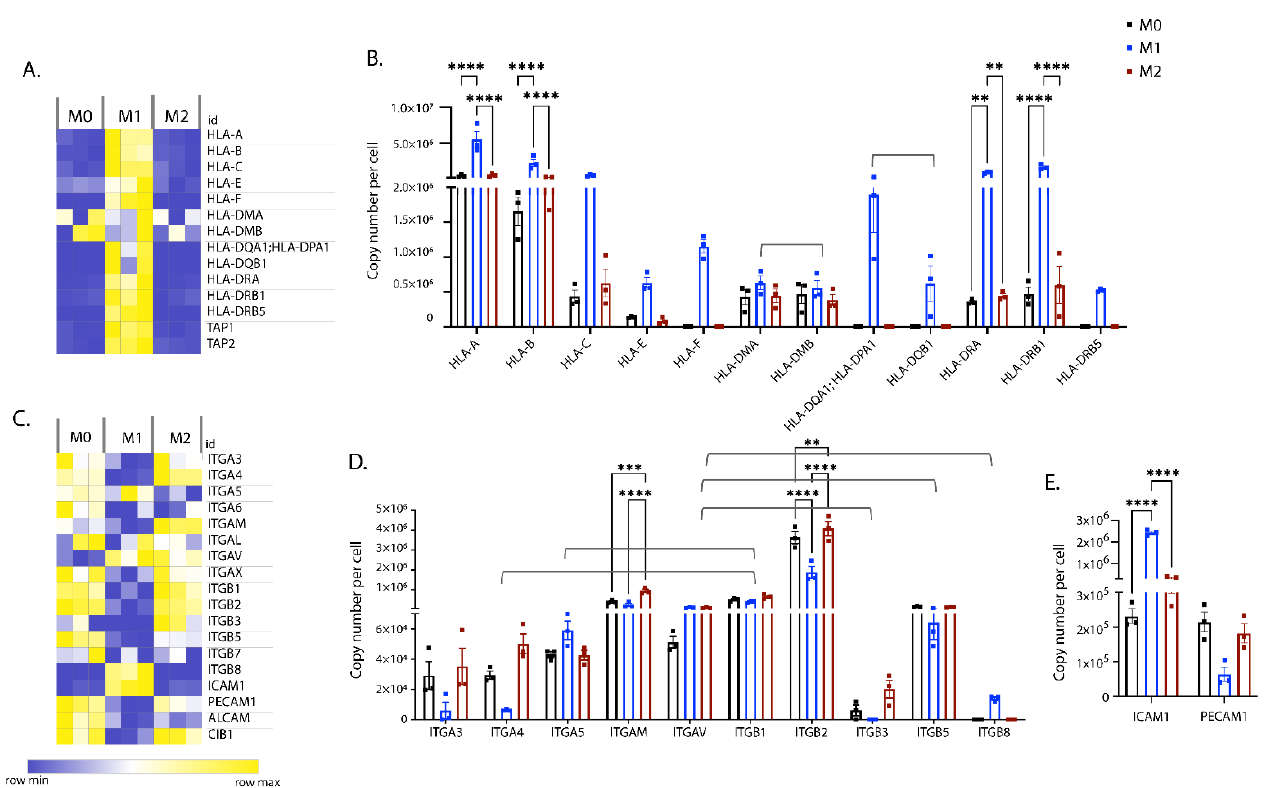
Figure 6. Expression levels of MHC and cell adhesion molecules. Heat map showing concentrations (in nM) of HLAs ( A ) and adhesion molecules ( C ) across biological replicates of differentially polarised iPSDM. Graphs show the estimated copy numbers per cell of HLAs ( B ), integrins ( D ) and cell adhesion molecules (CAMs) ( E ) using a Proteomic ruler. p values: ** 0.01, *** 0.001, ****